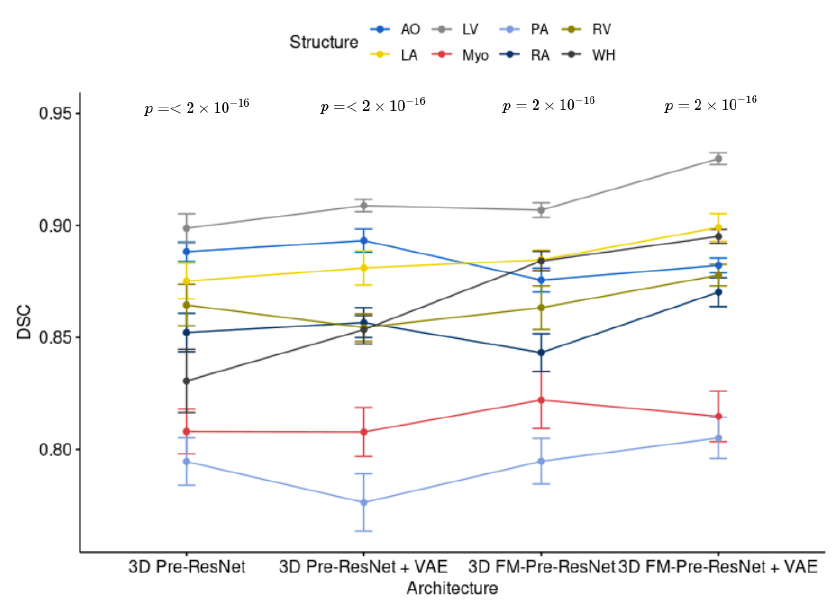
Figure 9. Comparison of Wilcoxon rank sum test of each heart structure for different architectures on the MMWHS MRI testing